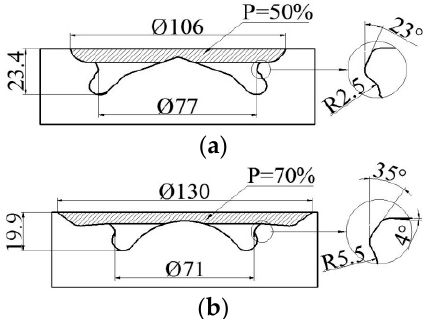
Figure 3. Profiles of the two DLDC chambers. ( a ) Profile of type I DLDC chamber; ( b ) profile of type II DLDC chamber.